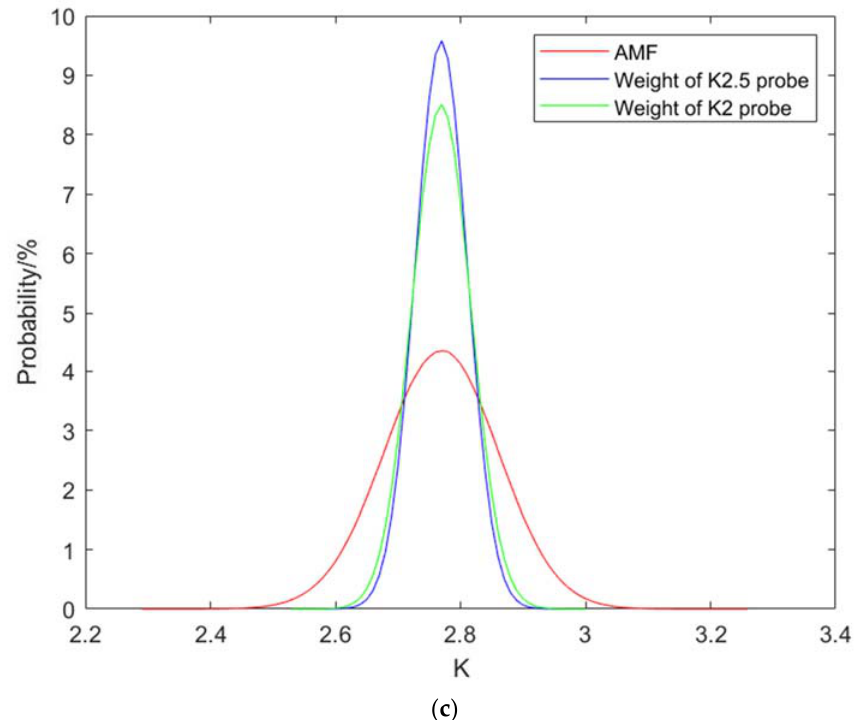
Figure 9. Results of fusion K of ( a ) K1.5, ( b ) K2 and ( c ) K2.5 probes by another probe weights.